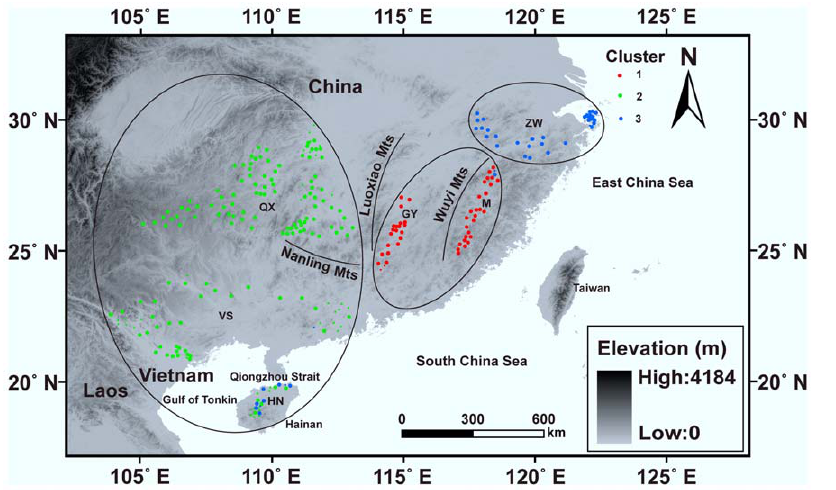
Figure 1. Three genetic clusters of Najaatra in China and Vietnam based on the admixture model in Structure. Individuals are represented by a point which is colored to reflect the cluster to which it was assigned with the highest membership coefficient. Large points represent individuals with membership coefficient q $ 0.90 and small ones q , 0.90. Ellipses show the three main genetic clusters. See Table 1 for sample site abbreviations.